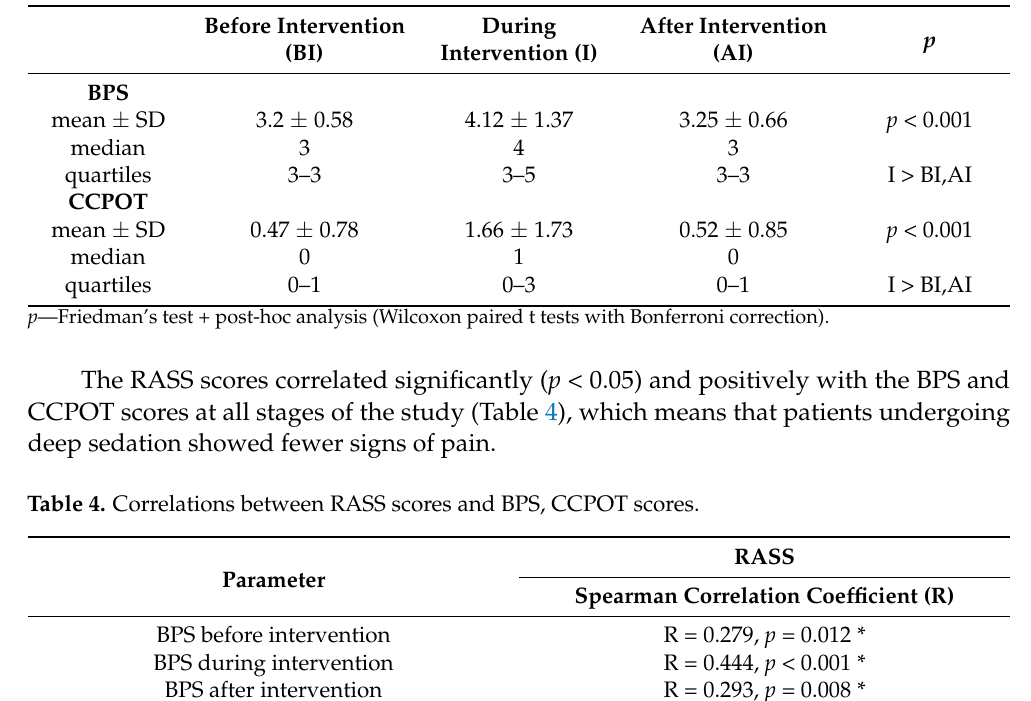
Table 3. Mean BPS and CCPOT scores in all measures ( n = 1005).